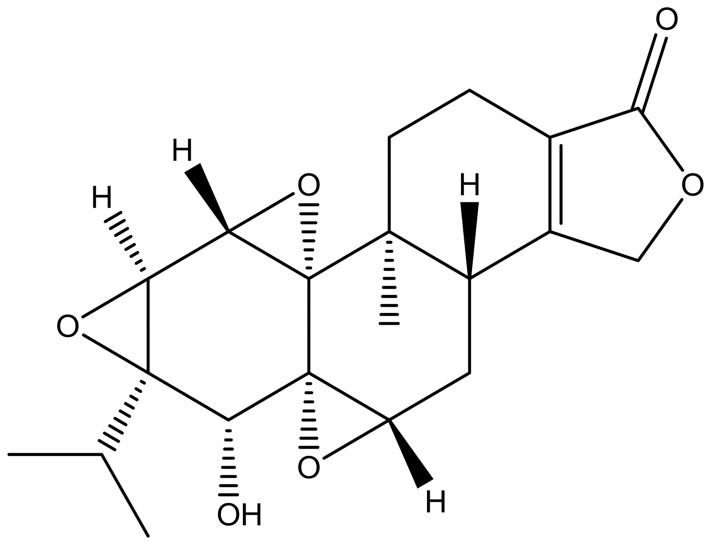
Structure of triptolide.